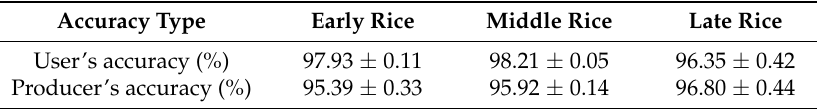
Table 2. Accuracy assessment of paddy rice classification.